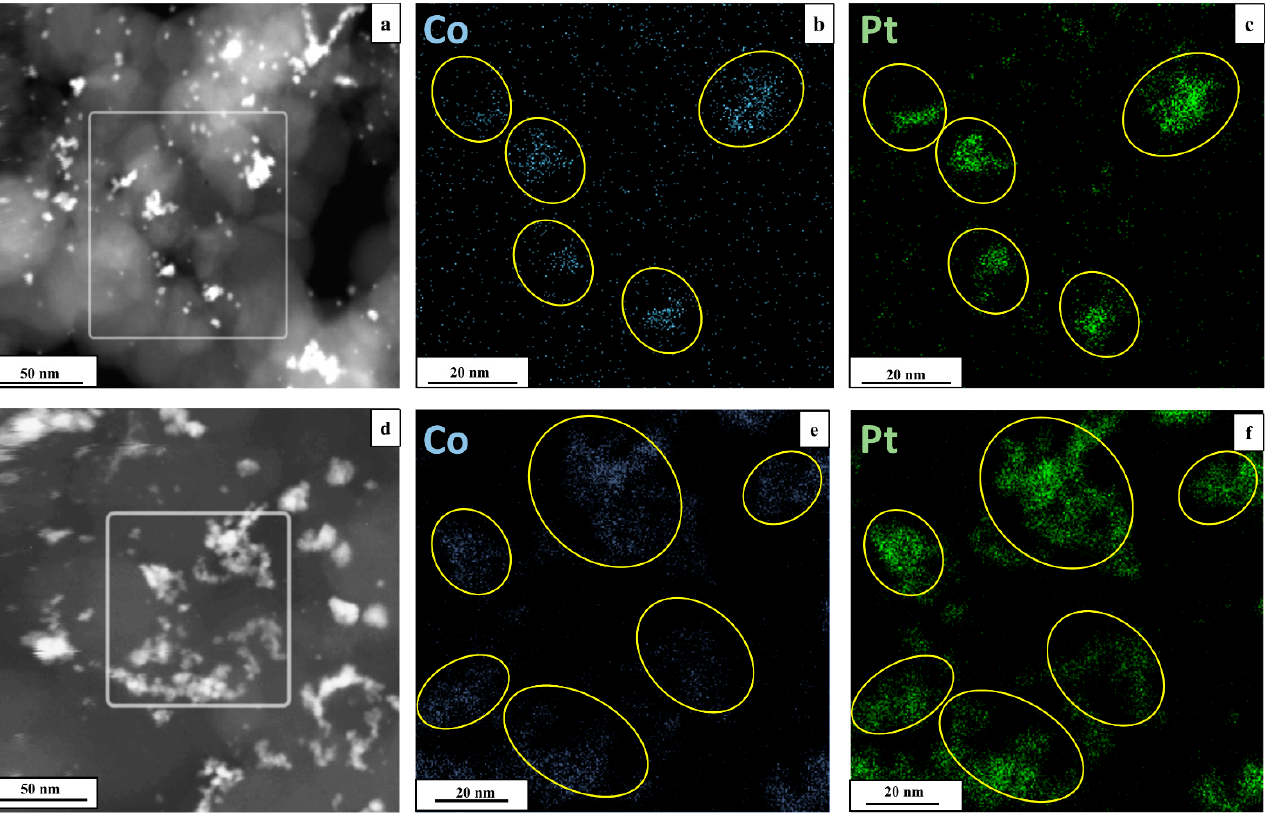
Figure 4. Elemental mapping of PtCo/C surface fragments for PCC1 ( a – c ) and PCC2 ( d – f ) samples.